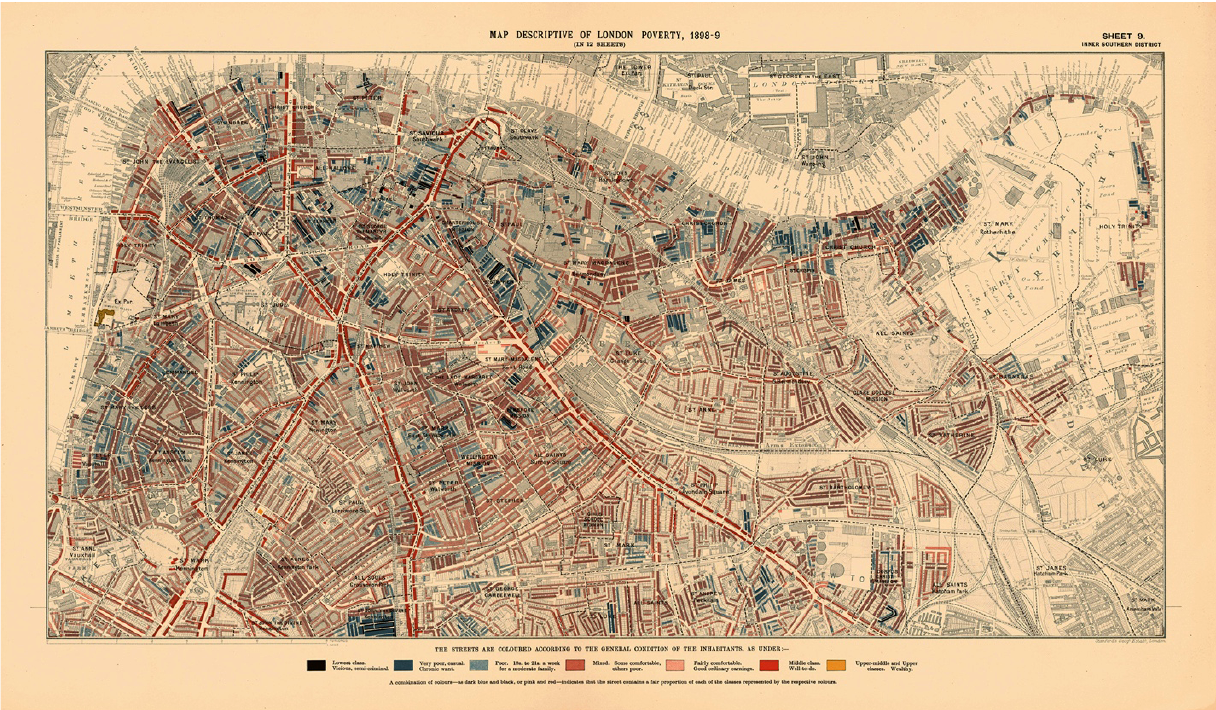
Figure 2. Example of a thematic map of poverty in south-east London: Map Descriptive of London Poverty, 1898–1899. Sheet 9. Inner Southern District (Booth, 1898). © 2016 London School of Economics and Political